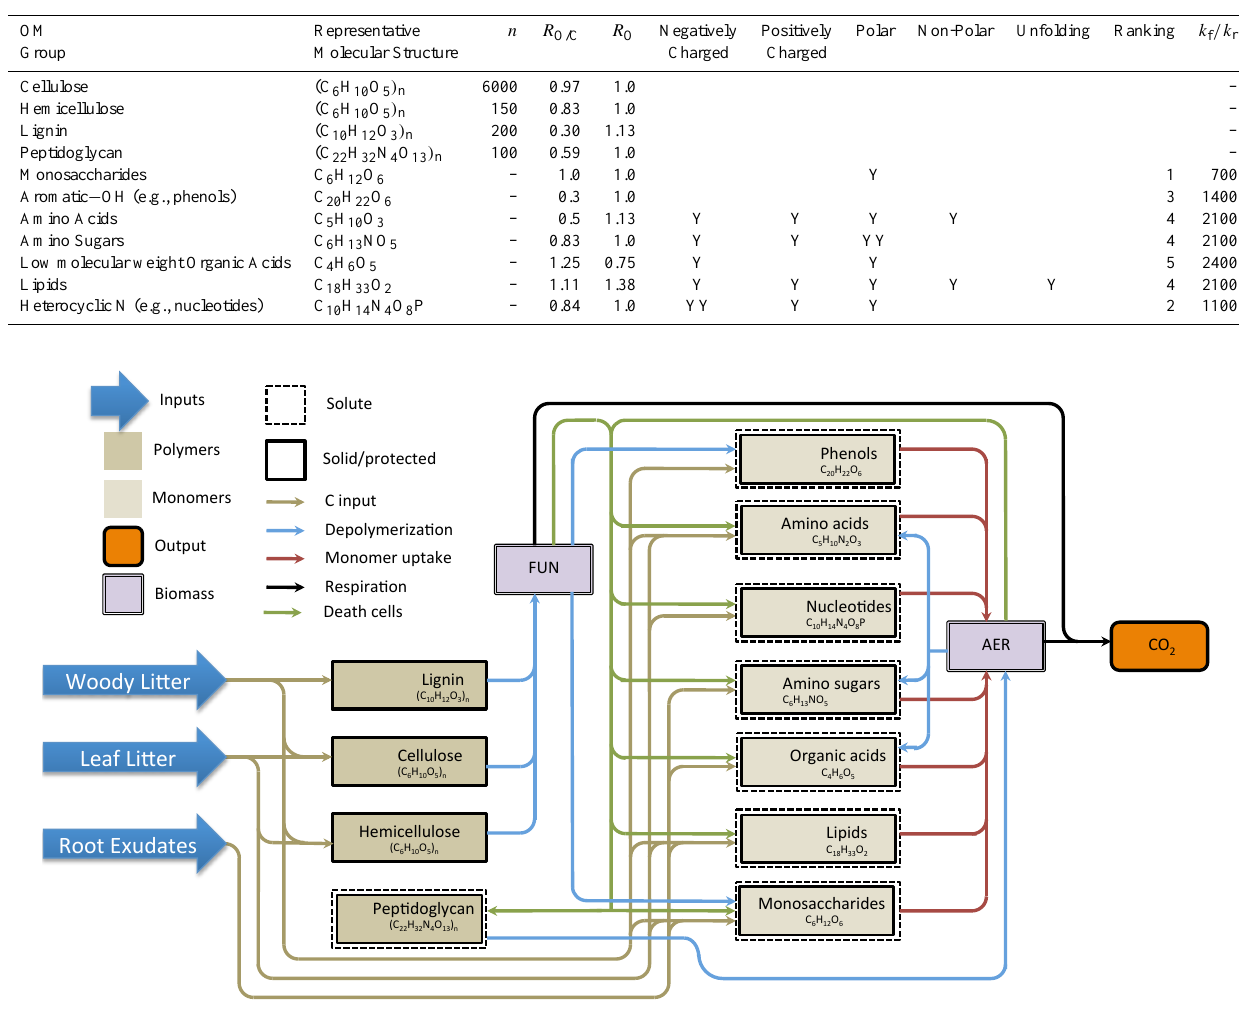
Figure 1. Reaction Network Diagram. FUN and AER stand for fungi and heterotrophic aerobic bacteria, respectively.